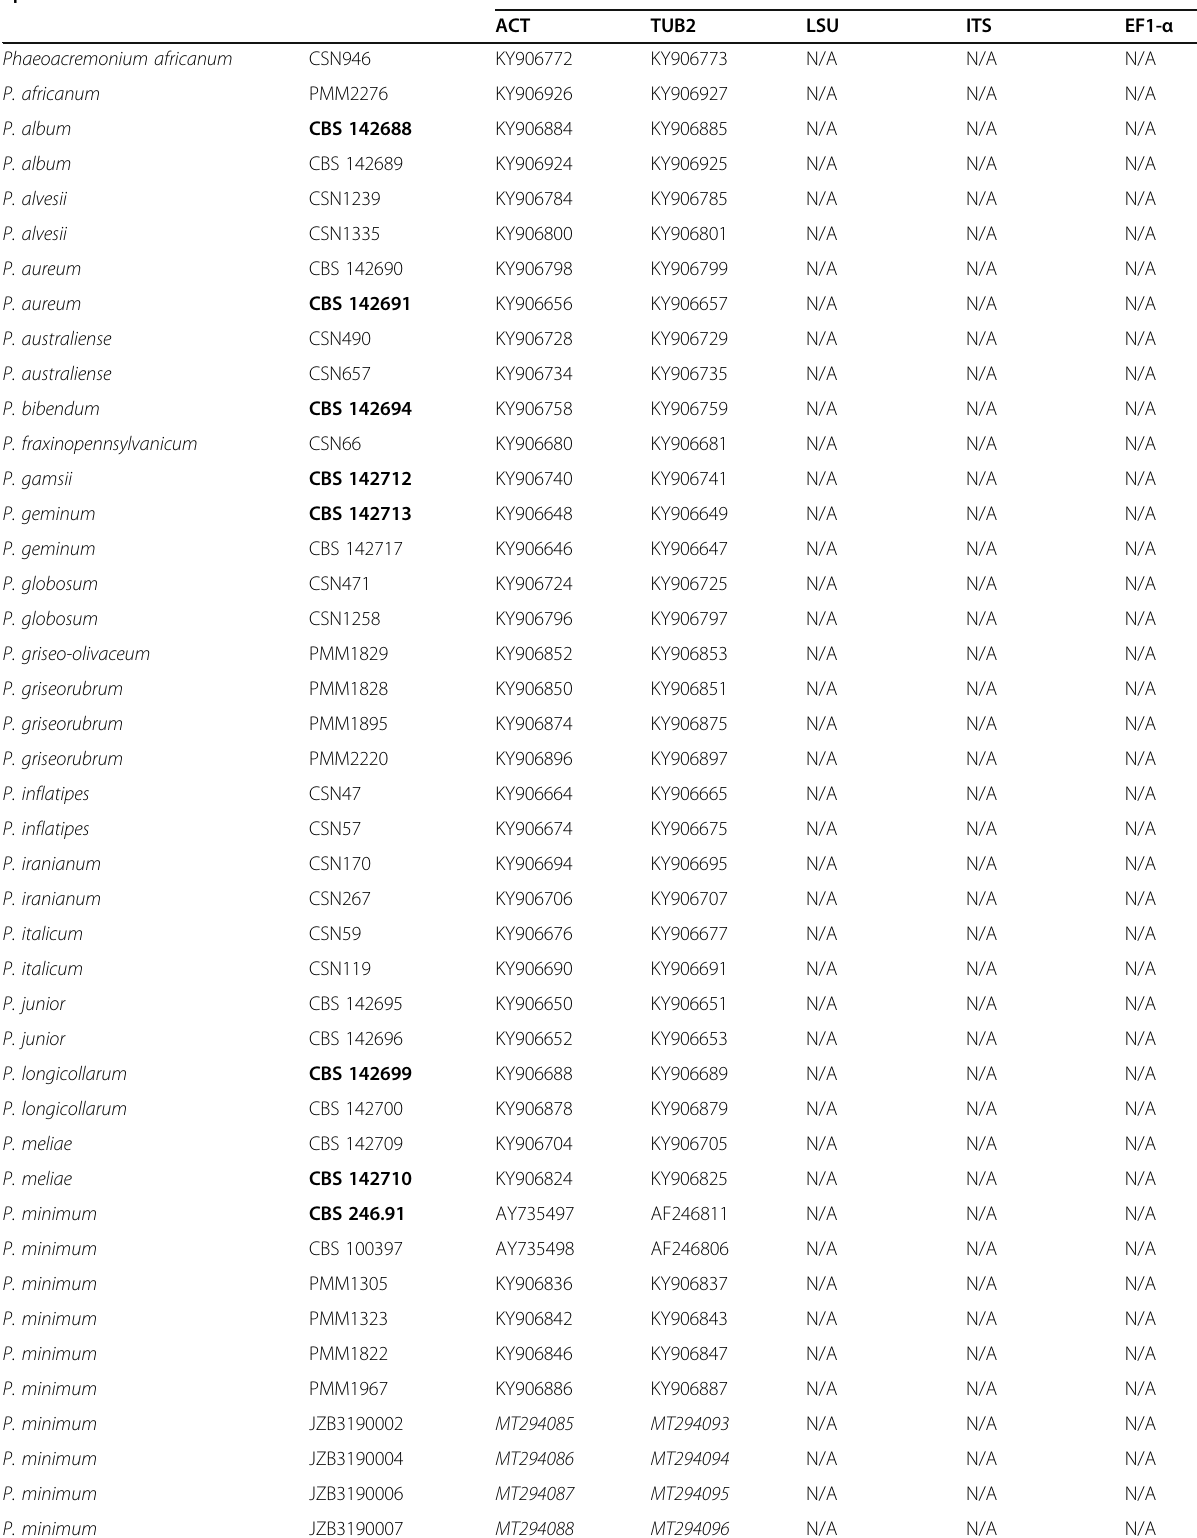
Table 2 Isolates and GenBank accession numbers of Phaeoacremonium and Fomitiporia species in this